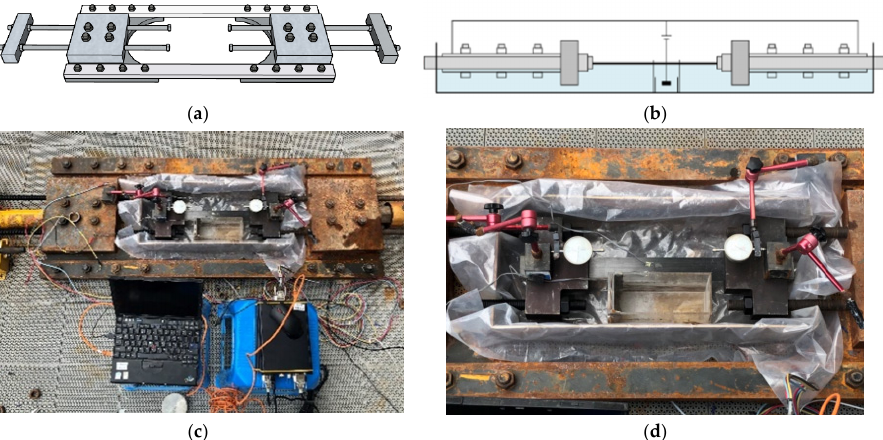
Figure 2. Test setup for pretensioning and accelerated corrosion: ( a ) frame for pretensioning, ( b ) electric circuit, ( c ) overview, and ( d ) close-up view for acceleration corrosion.